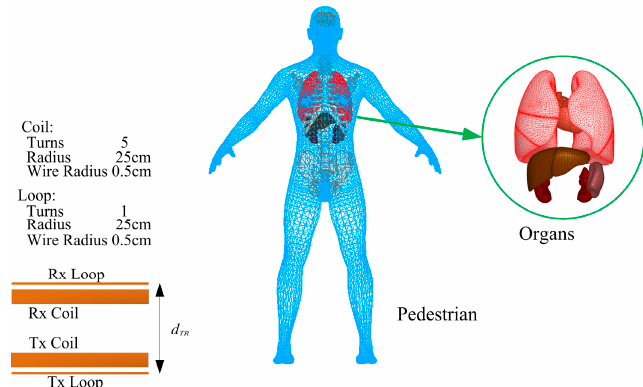
Figure 1. Three-dimensional (3D) finite element analysis (FEA) numeric model of adult and wireless power transfer (WPT) coils. Rx: pick-up; Tx: transmission.